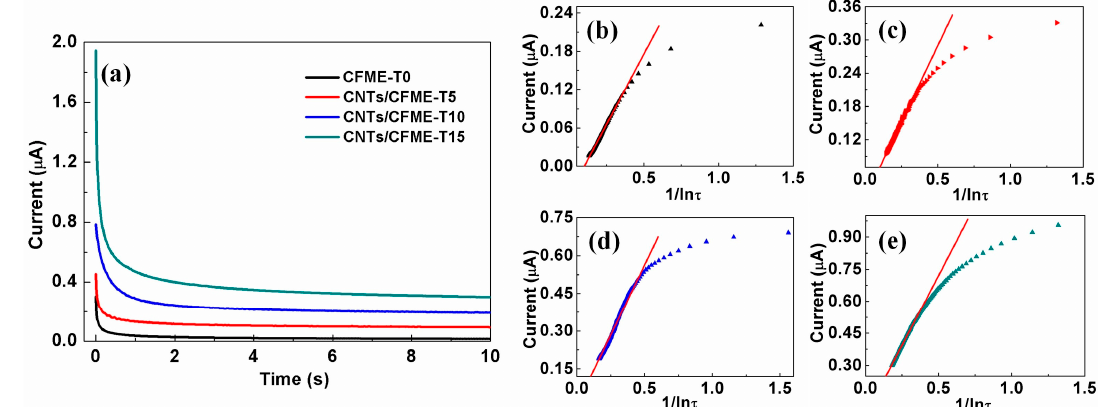
Figure 8. ( a ) The chronoamperogram of the CFME and CNTs/CFMEs in 5.0 mM K 4 Fe(CN) 6 (in 1.0 M KCl) by applying a step potential of 0.35 V; Plots of chronoamperometry response current vs. l/ln τ of ( b ) CFME-T0; ( c ) CNTs/CFME-T5; ( d ) CNTs/CFME-T10 and ( e ) CNTs/CFME-T15, respectively. Table 2. The linear fitting equations of the i qss versus 1/ln τ .